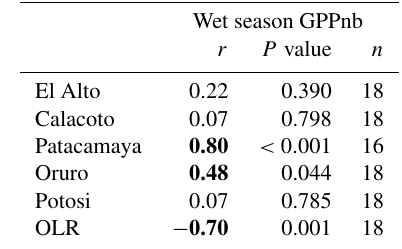
Table 2. Spearman’s correlations between giant particle percent- age (GPPnb), rainfall observations, and outgoing longwave radia- tion (OLR). All data refer to the wet season (December–January– February). The annual cycle of the meteorological data was re- moved by subtracting the monthly means. Outliers were also re- moved. Correlation coefficients ( r ) that are significant at the 95% level are shown in bold. The P values for each correlation, as well as the number of data points ( n ), are also